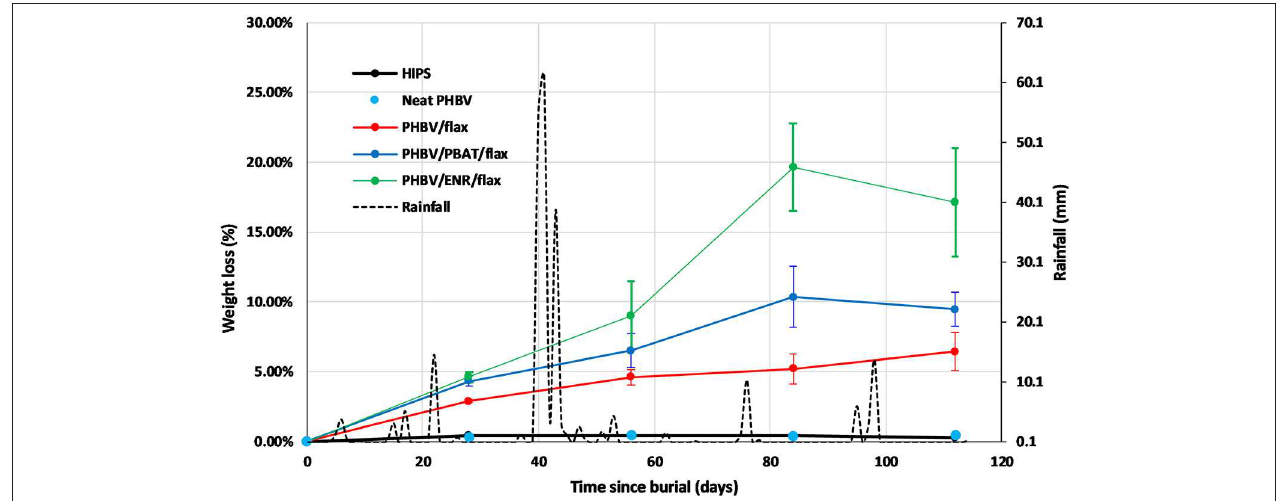
FIGURE 3 | Mass loss curves of HIPS control, neat PHBV, PHBV/flax, PHBV/PBAT/flax, PHBV/ENR/flax, and rainfall data for May to August 2017 period. Error bars represent standard deviation for n = 3 samples.